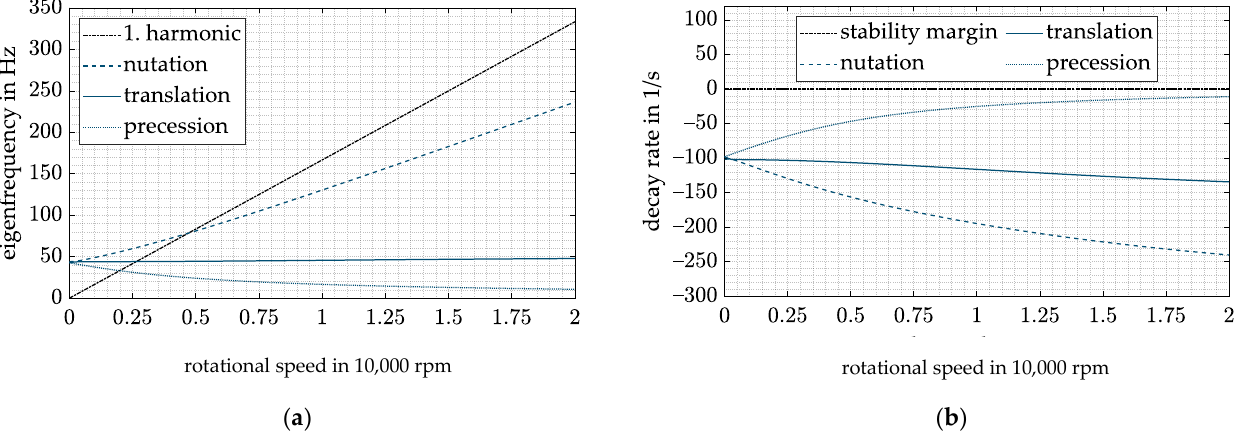
Figure 12. DVFC and worst-case design for best-case combination of all uncertainties: ( a ) Campbell diagram; ( b ) decay rate.